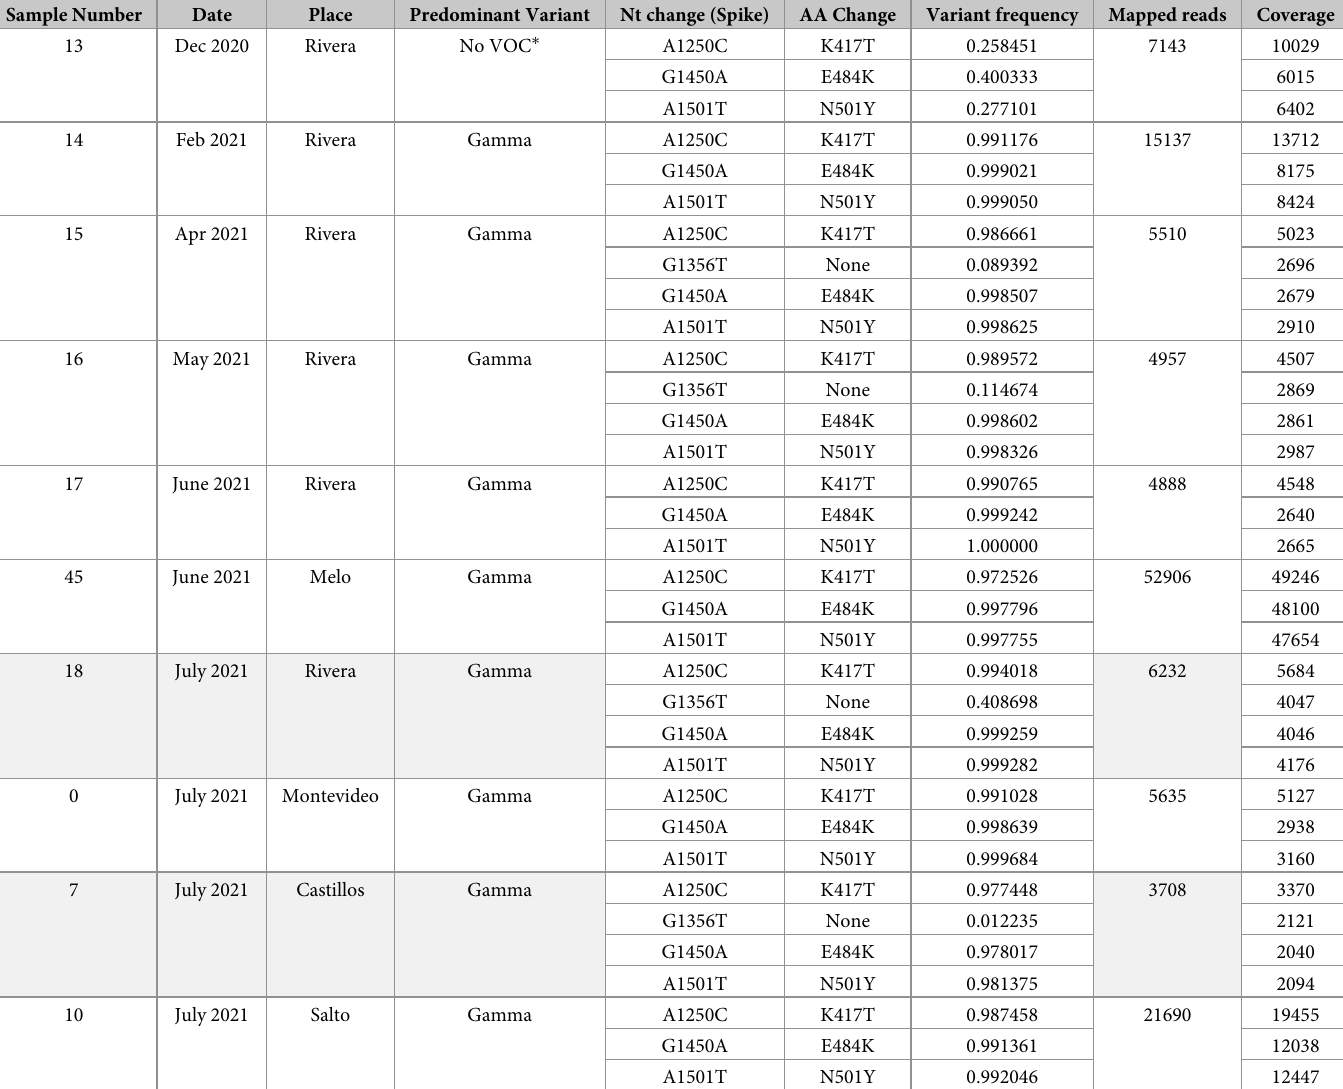
Table 1. Analysis using the LoFreq